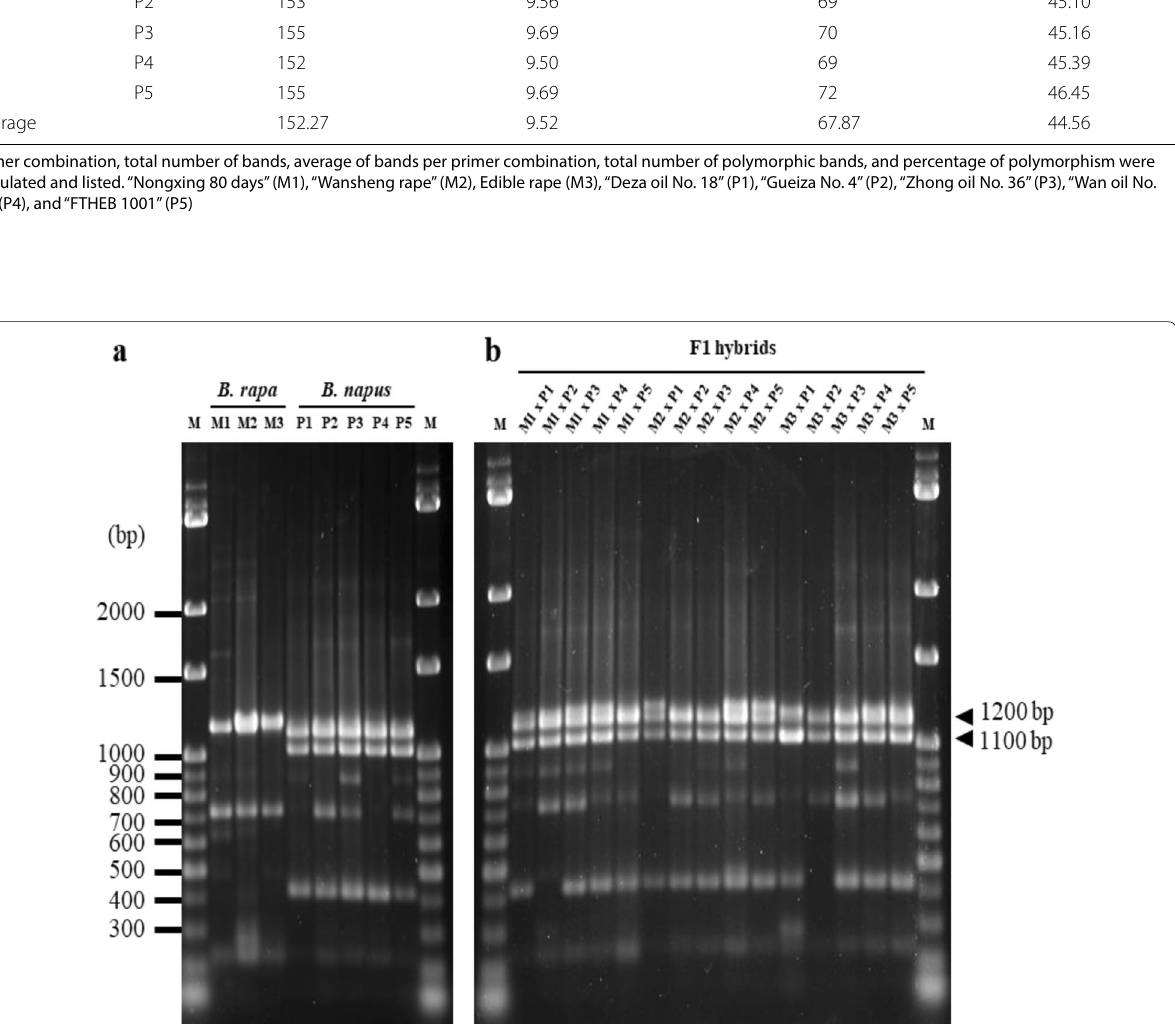
Table 3 SRAP marker analysis of the F